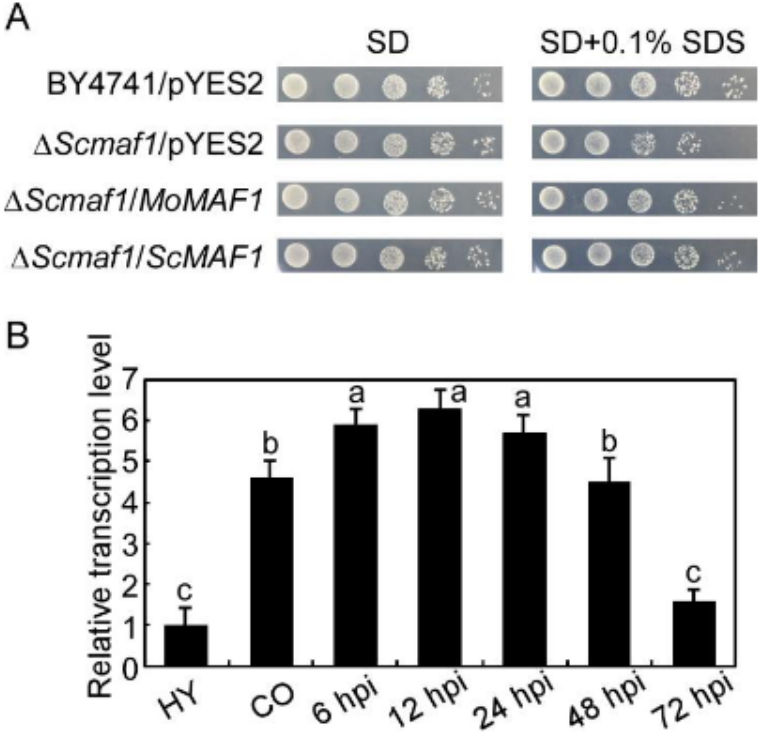
Figure 1. Expression profiles of MoMAF1 at different developmental stages in M . oryzae determined by yeast complementation assays: ( A ) MoMAF1 partially suppressed the growth defect of ∆ Scmaf1 mutant yeast under 0.1% SDS stress. Photographs were taken at 4 days. ( B ) Expression levels of MoMAF1 at different stages in M . oryzae . Expression in the hyphal stage was used as an internal reference, and error bars represent the standard deviation (SD). Values on the bars followed by the same letter are not significantly different at ( p < 0.05).